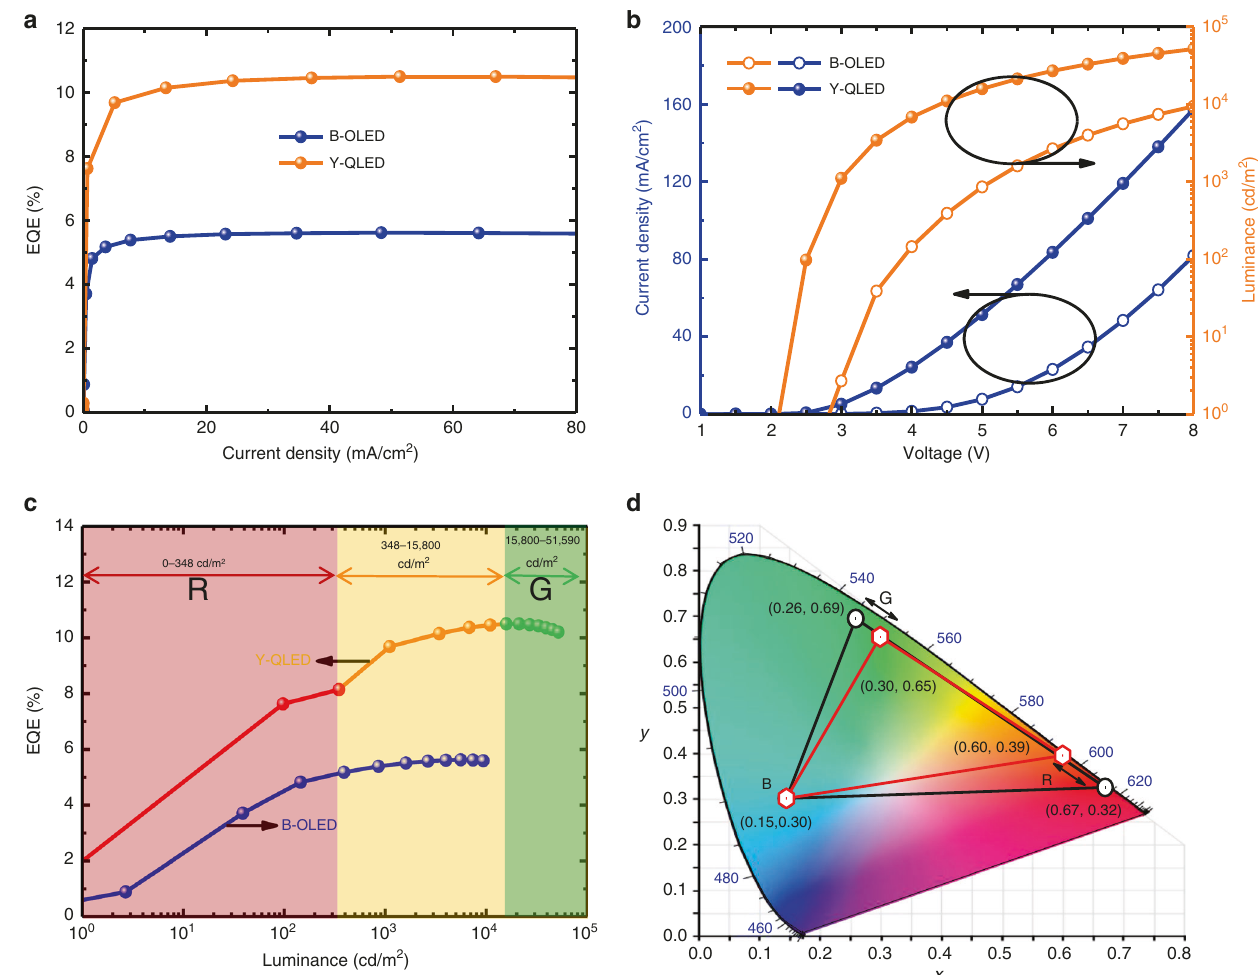
Fig. 3 Performance of the full-color-tunable LED. a The EQE – J , b J – V – L, and c EQE – L characteristics of B-OLED and Y-QLED, measured by extracting the IZO as a common electrode. d CIE chart and color coordinates of the R, G, and B primary colors. By degrading the color gamut from 63% to 45% NTSC, a wide range of brightness for the R, G, and B emission can be